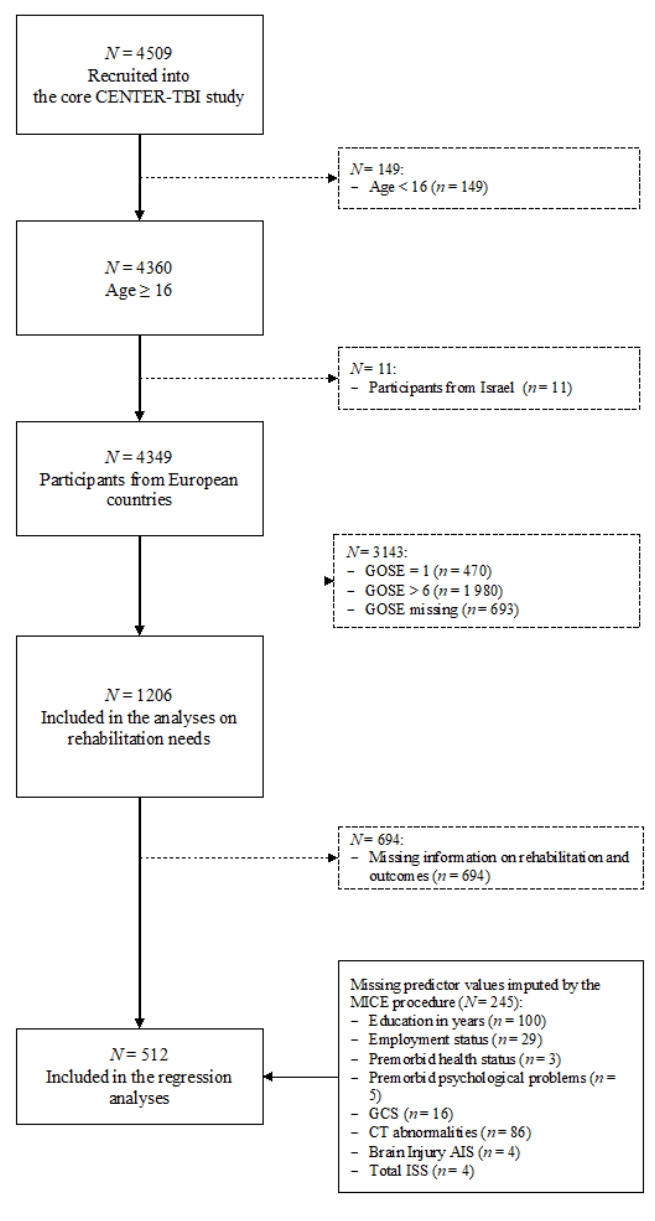
Figure 1. Sample attrition